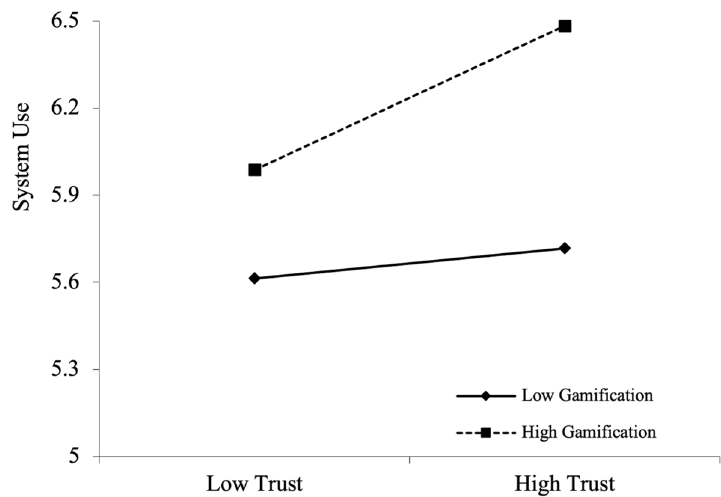
Fig. 3 Two-way interaction effects for regression analysis with system use (dependent variable, axis Y), trust (independent variable, axis X), and gamification as a moderator. All variables are measured by Likert scale from 1 (strongly disagree) to 7 (strongly